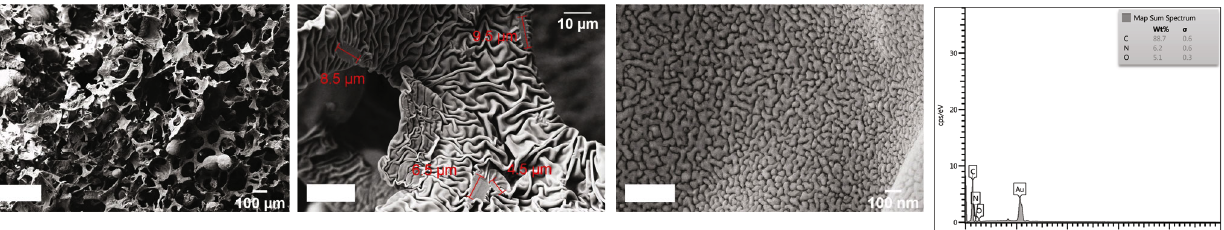
Figure 18: SEM images and energy-dispersive spectroscopy (EDS) analysis of PURFs PU-S4-3.